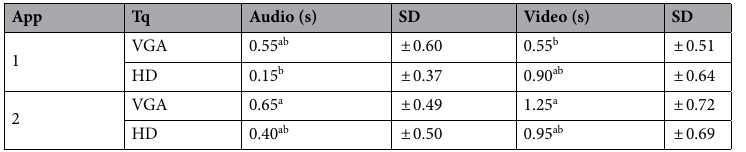
Table 3. Lag time (s) for audio and video transmission from M400 to laptop, using Vuzix Remote Assist (App1) and Brochesia B View (App2) applications. Two transmission qualities (Tq) were tested. Values with different letters in the column are significantly different ( P < 0.05).